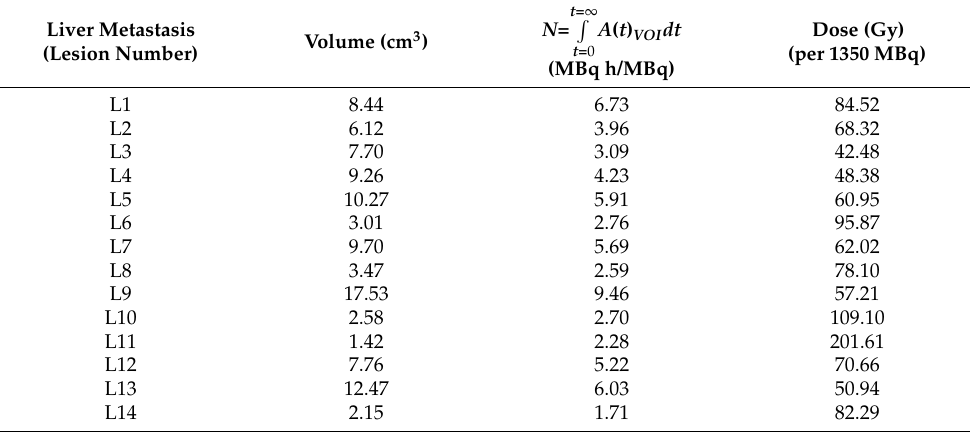
Table 8. Total number of nuclear transformations (N) and radiation absorbed doses (Gy/1350 MBq) of 177 Lu 2 O 3 -iPSMA nanoparticles in liver metastases, from a patient with metastatic colorectal cancer. Liver Metastasis (Lesion